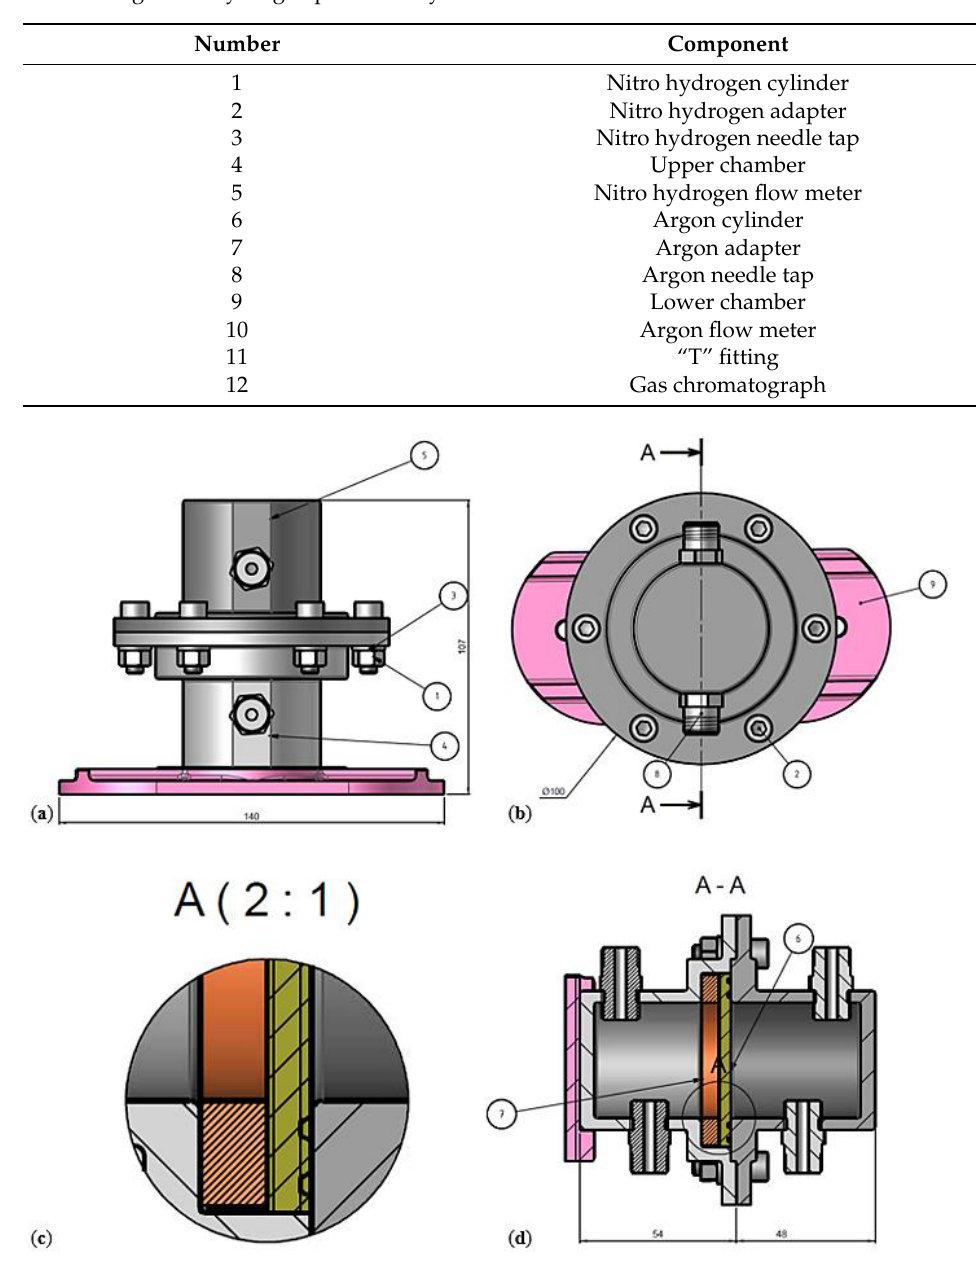
Figure 2. Design of hydrogen permeability test chamber. ( a ) Front view; ( b ) top view; ( c ) position of the specimen; ( d ) lateral section.